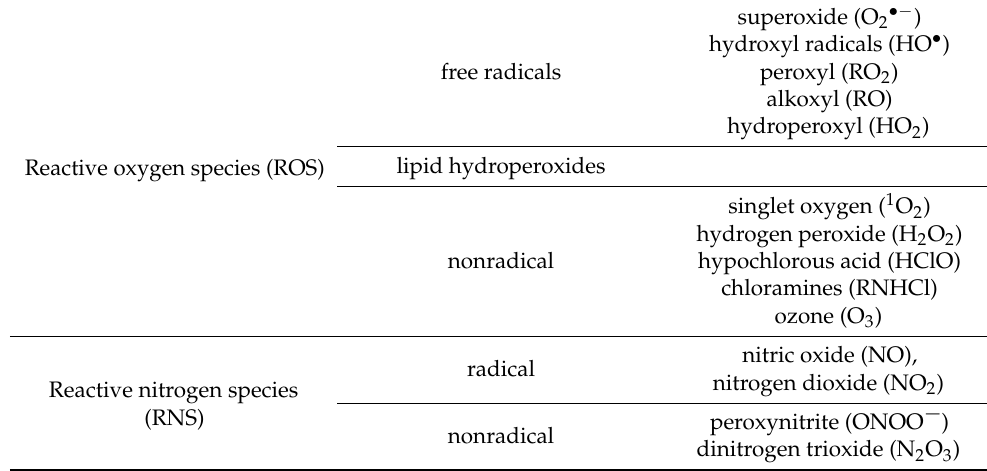
Table 1. Overview of reactive molecules causing oxidative